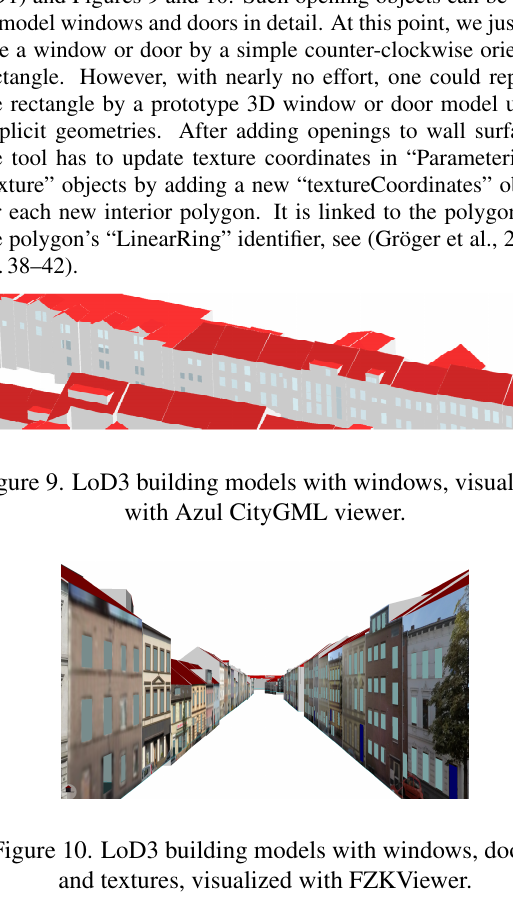
Figure 10. LoD3 building models with windows, doors and textures, visualized with FZKViewer.